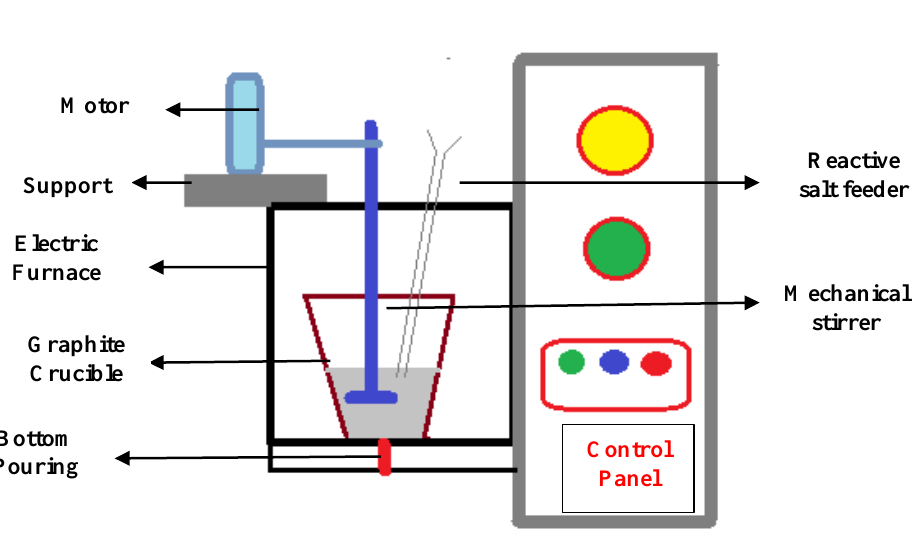
Fig. 2. Schematic diagram of bottom pouring mechanical stir casting